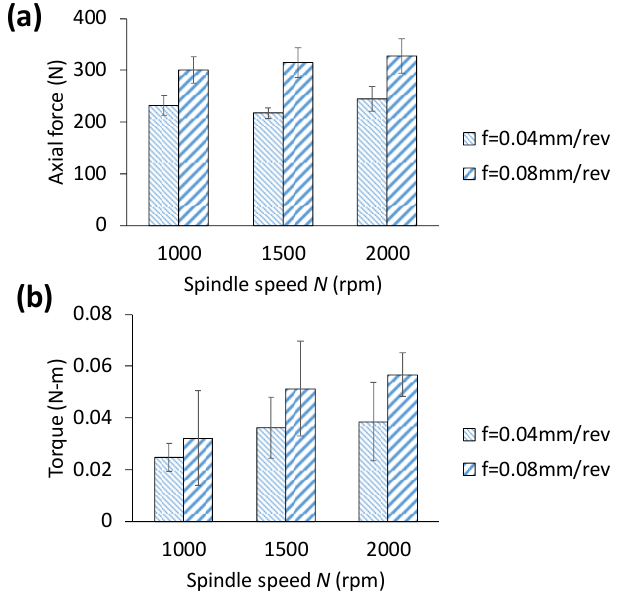
Figure 4. Effect of feedrate and spindle speed on ( a ) average axial force and ( b ) average torque. Error bar indicates standard deviation of force data for drilling of 10 holes.